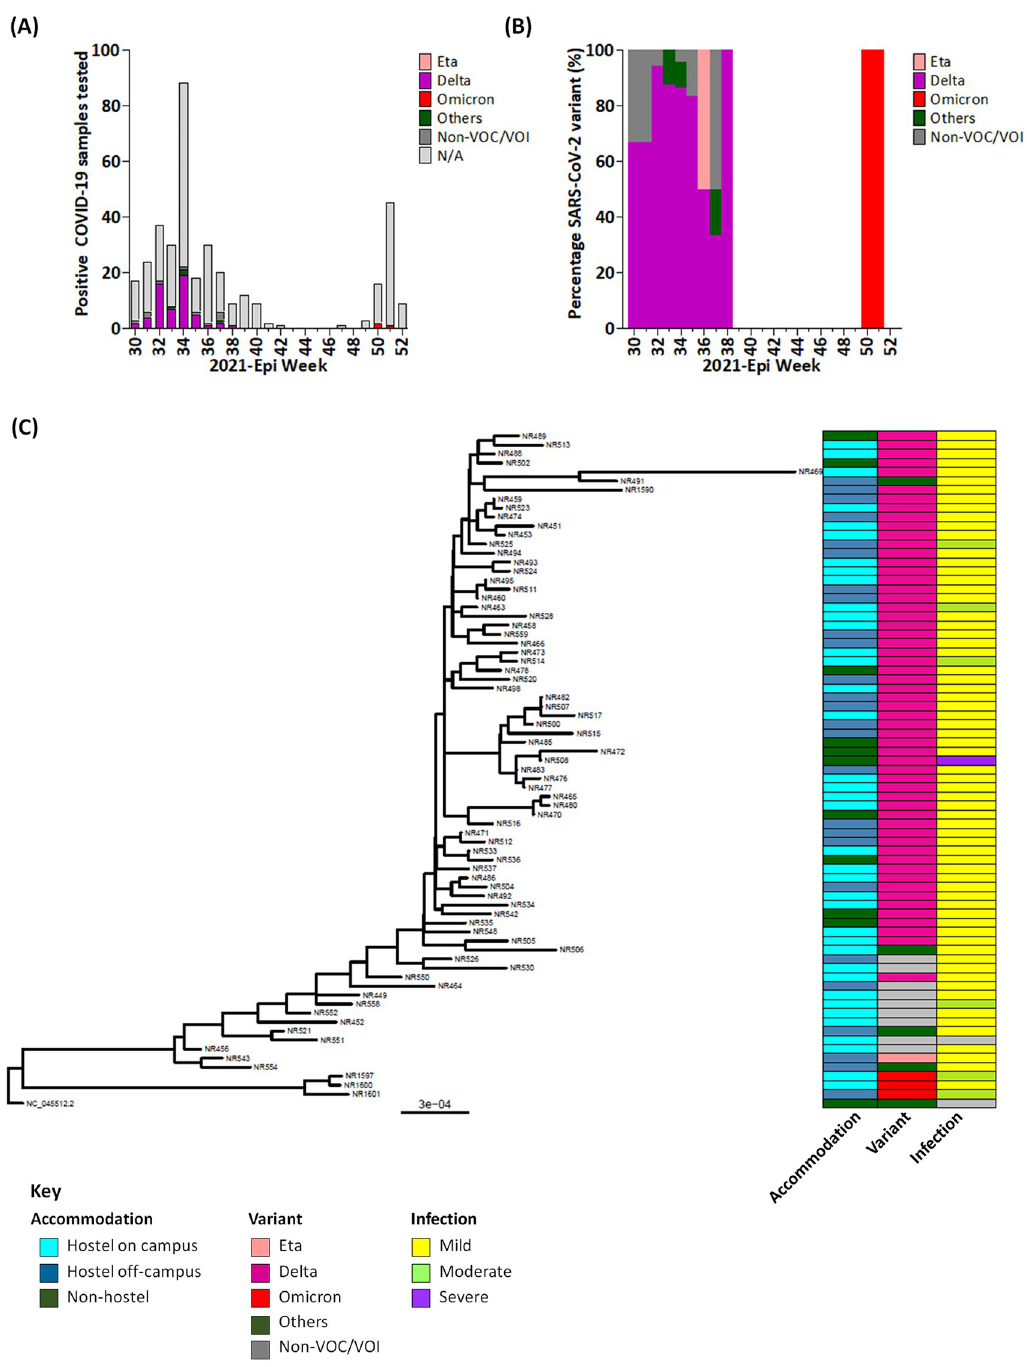
Fig 2. (A) Weekly positive COVID-19 samples showing distribution of variants in circulation during outbreaks. Figure shows the non-VOC/VOI (dark grey), Eta (pink), Delta (magenta) and Omicron (red) and other VOC/VOI (green). Non-sequenced samples termed not applicable (N/A) are also shown (light grey). (B) Percentage VOC/VOI Epi-weekly. non-VOC/VOI (dark grey), Eta (pink), Delta (magenta) and Omicron (red), and other VOC/VOI (green). (C) The maximum likelihood phylogenetic tree inferred from SARS-CoV-2 genomic isolates from the University community. Tips are labelled with specimen’s identification numbers corresponding with GISAID assigned accession numbers in S1 Table. The heatmap from first to third columns (left to right) indicates the accommodation type, variants of concern (VOC), and severity of infection respectively. Variant column was coloured with the major variant assigned by GISAID. The scale bar indicates distance substitution per site.